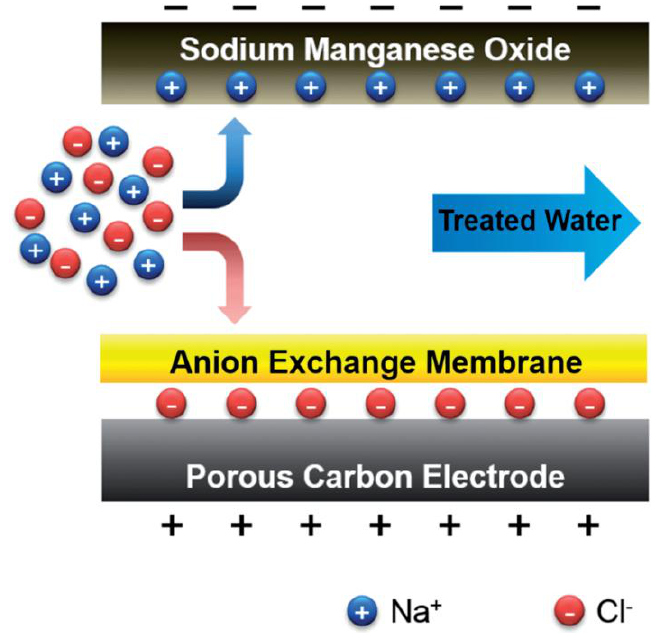
Figure 11. Schematic diagram of hybrid capacitive deionisation (HCDI). Reproduced with permission from Lee et al. [133], copyright Royal Society of Chemistry, 2014.